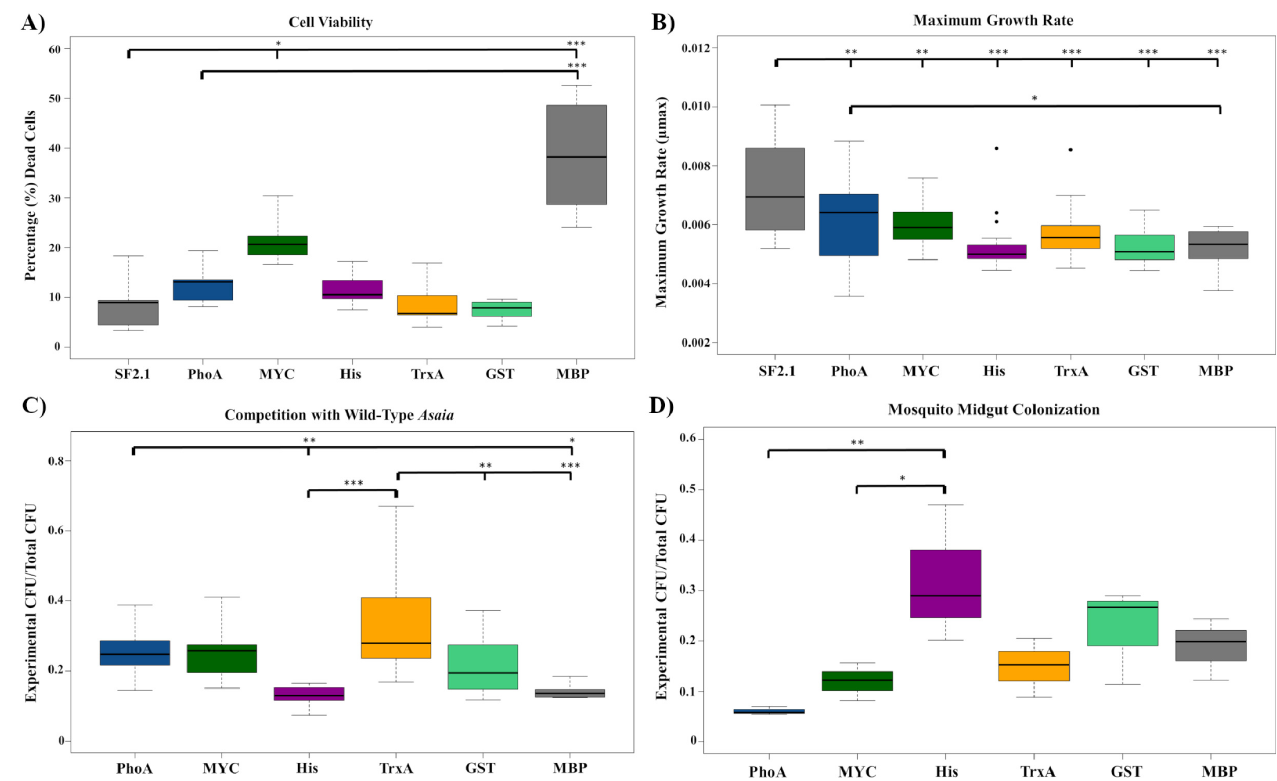
Fig 3. Fitness assessments of antiplasmodial Asaia strains. ( A ) Cell viability of Asaia strains on solid media. The Myc and MBP strains had the highest significant percentage of dead cells while SF2.1, TrxA and GST had the lowest percentage. ( B ) Growth curves and maximum growth rates ( μ max) were calculated from individual isolates of each strain. Only MBP showed a significantly lower μ max than the PhoA strain. ( C ) Each strain was competed in mannitol media with wild-type Asaia SF2.1. Ratios of transgenic vs. whole culture CFUs are displayed. A 50:50 ratio indicates no loss of the paratransgenic strain during the course of the experiment. ( D ) Relative colonization of mosquito midguts by antiplasmodial Asaia strains. The His strain had the highest rate of colonization, followed by the GST strain; the PhoA strain had the lowest rate of colonization. Statistical significance for each experiment was determined using one-way ANOVA with Dunnett’s correction where significance is represented by � P < 0.05, �� P < 0.01, and ��� P < 0.001 with experimental replicates (A. n � 18, B. n � 10, C. n = 3). Only significant comparisons are shown.